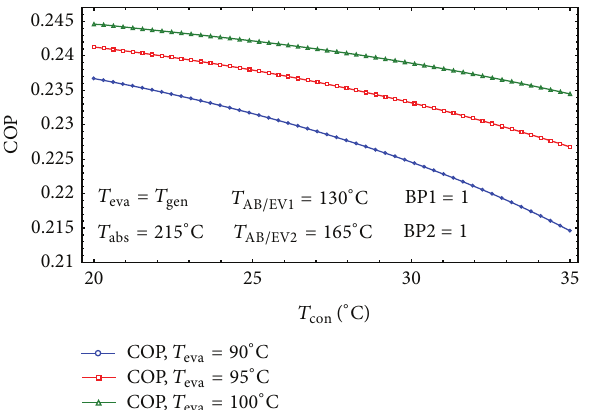
Figure 12: The effect of 𝑇